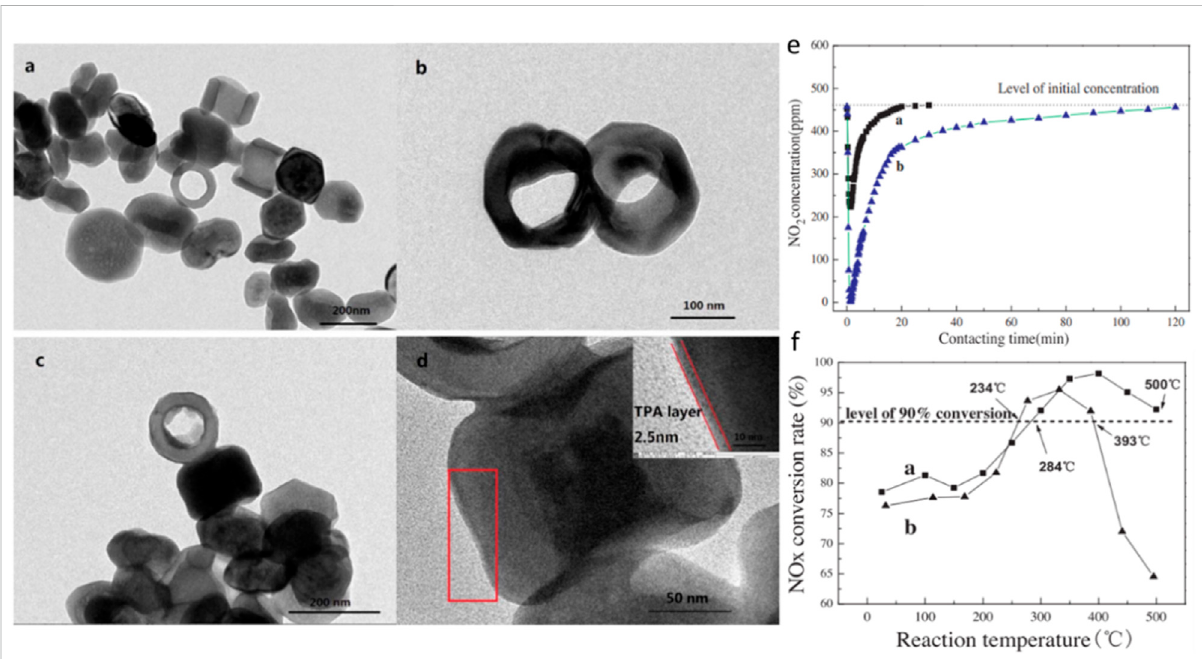
FIGURE 6 Microwave-assisted loading of phosphotungstic heteropolyacids on Fe 2 O 3 surfaces: (A – D) Microstructure: (E) NO 2 adsorption effect; (F) NO x removal effect (Ren et al., 2017b).